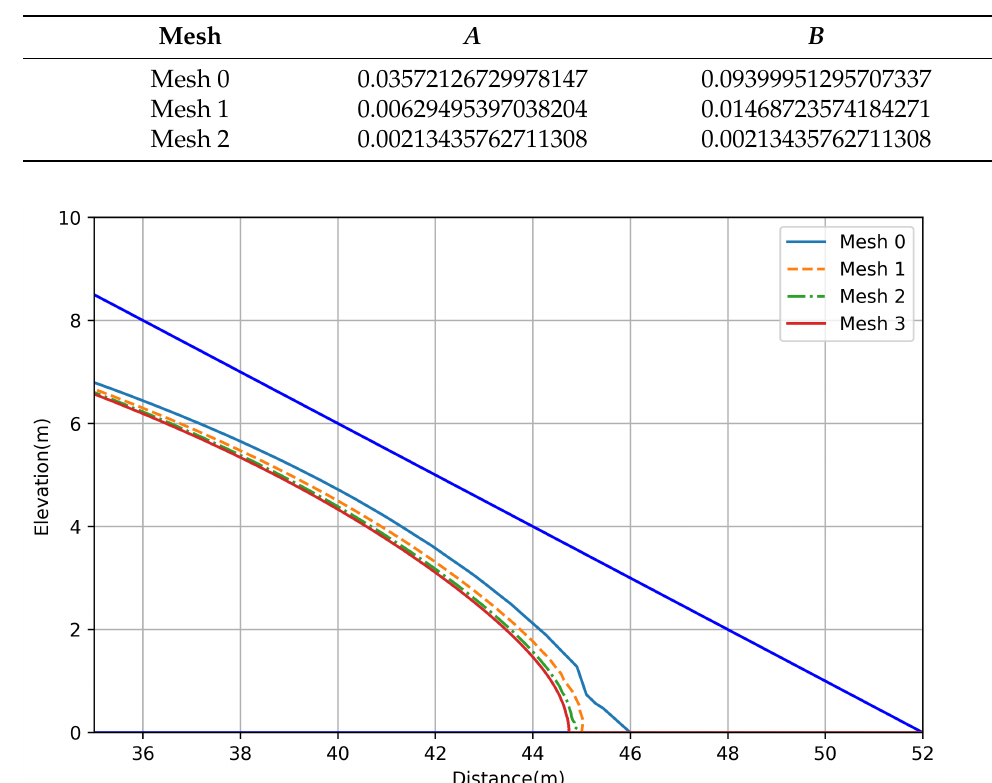
Figure 3. The phreatic level calculated in the finest mesh (d) shown in Figure 2. Table 1. RMSE errors from the phreatic curves calculated in the meshes.